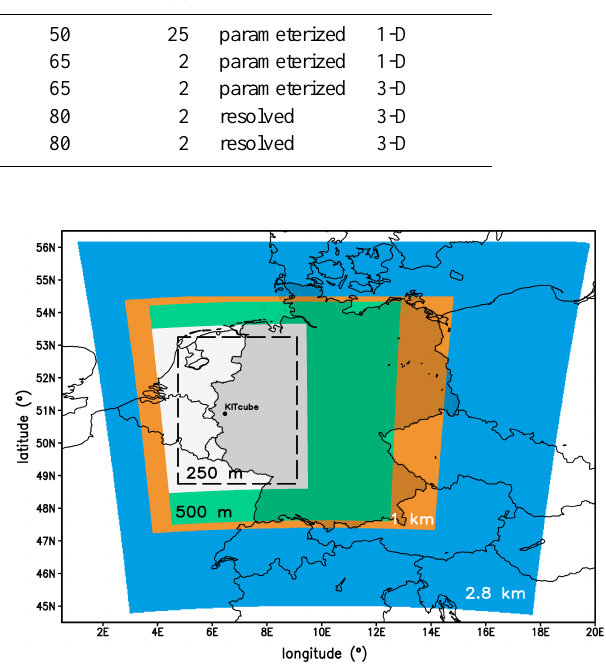
Figure 1. Simulation domains. The dashed rectangle indicates the common investigation area used in this study. The measurement area of the HOPE field campaign is located around the KITcube